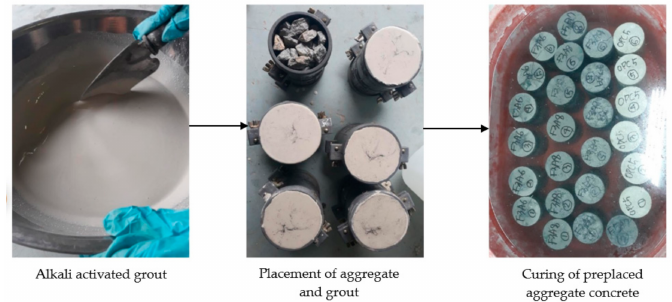
Figure 1. Fabrication of preplaced aggregate concrete